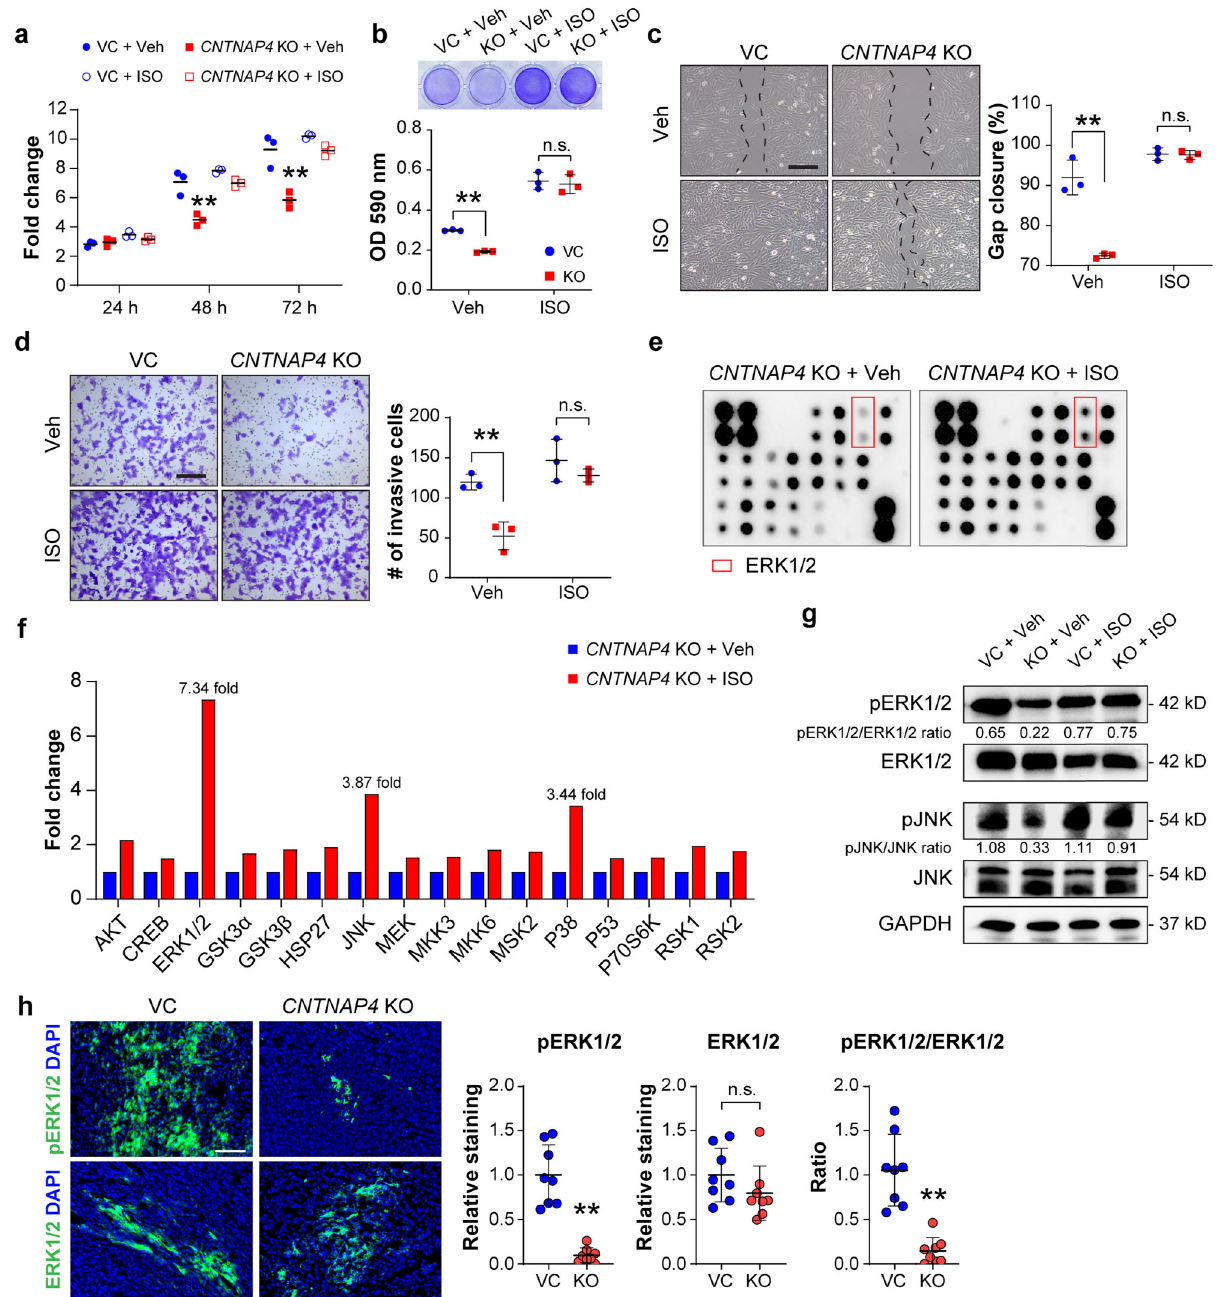
Fig. 4 ERK agonist restores cellular phenotypes in CNTNAP4 KO cells. Cells were pre-treated by vehicle control (Veh) or 1 μ M isoproterenol (ISO) for 5 min. a MTS proliferation assay among cells at 24, 48, and 72 h. b Attachment assay at 3 h, assessed by crystal violet staining (top) and quanti fi cation (bottom). c Migration assay at 24 h assessed by scratch wound healing assay (left) and quanti fi cation (right). d Transwell invasion assay at 24 h, including representative images (left) and quanti fi cation (right). Data shown as mean ± 1 SD, with dots representing individual data points. ** P < 0.01; n.s. not signi fi cant. Scale bars: 100 µm. e Protein array demonstrating MAPK phosphorylation in CNTNAP4 KO clones with or without ISO treatment. f Phosphorylation level of MAPK proteins measured as fold-change of the paired duplicate spots and normalized to positive control spots. g Western blot of pERK1/2, ERK1/2, pJNK and JNK. Ratio of pERK1/2/ERK1/2 and pJNK/JNK is listed below. h pERK1/2 and ERK1/2 immunostaining and quanti fi cation in 143B